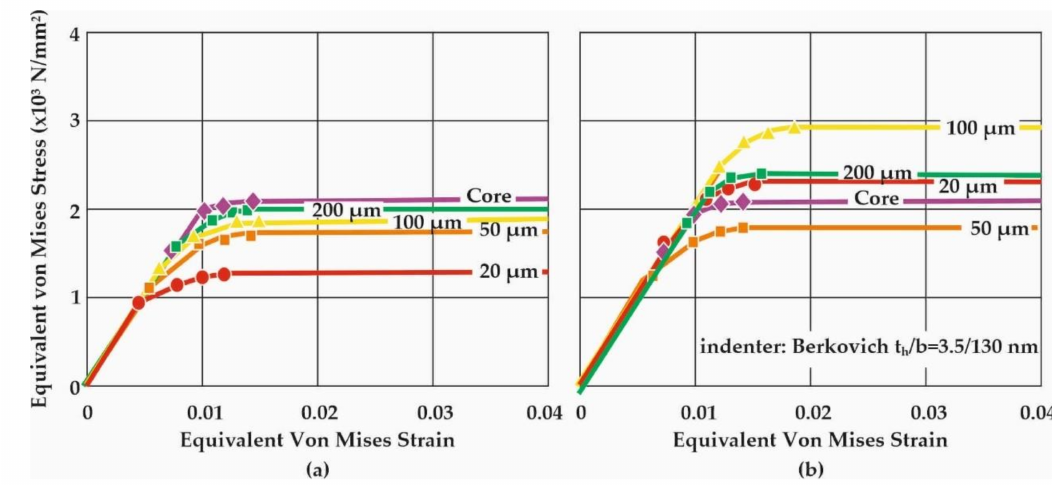
Figure 10. Equivalent von Mises stress–strain plots characterizing the behavior of ( a ) HTT and ( b ) HTT+SSP leaf spring specimens at distinct distances from the surface, calculated for the compressive nature of